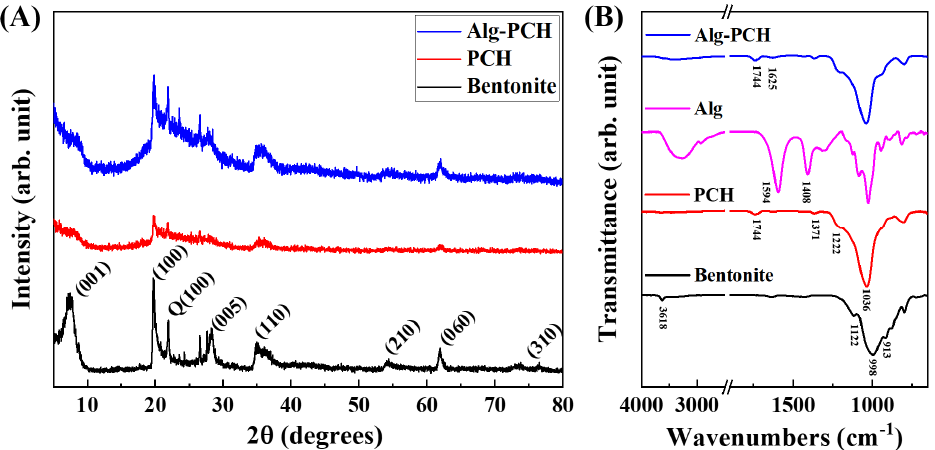
Figure 1. ( A ) Powder X-ray diffraction patterns of bentonite, PCH, and Alg-PCH (Q; quartz) and ( B ) FT-IR spectra of bentonite, PCH, alginate, and Alg-PCH.